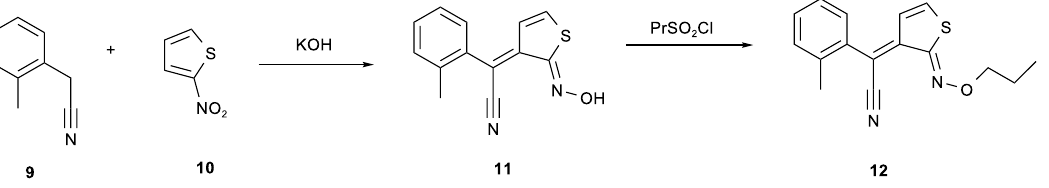
Figure 3. KOH catalysed condensation of o -xylyl cyanide 9 with 2-nitrothiophene 10 on route to photoacid generator PAG 103 12